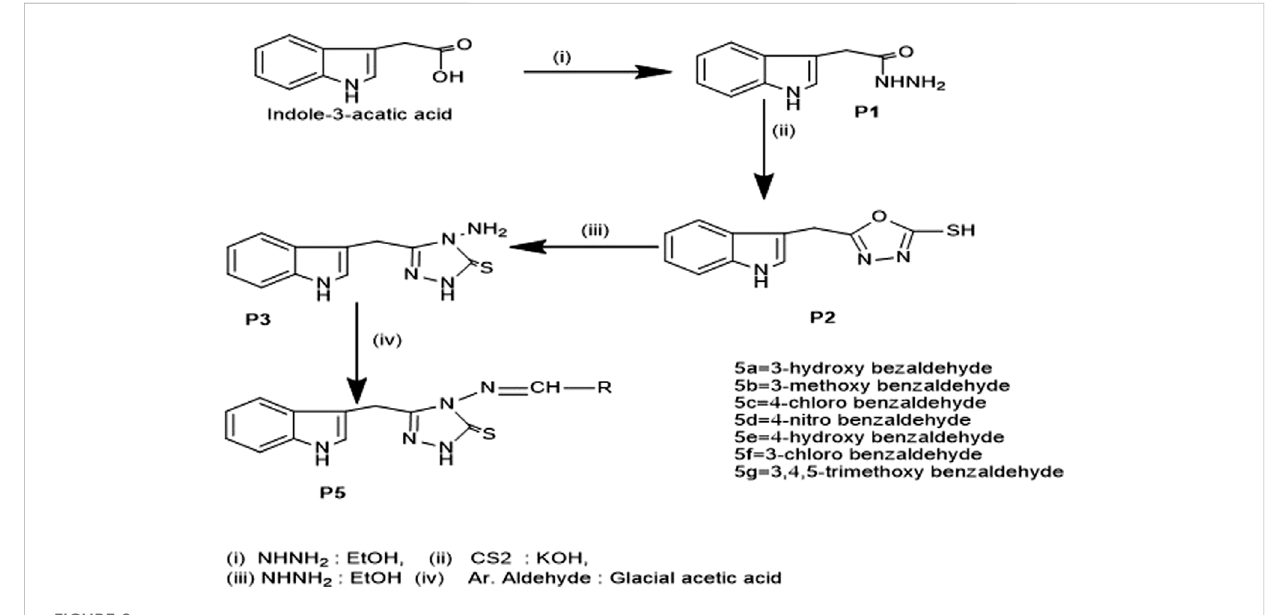
FIGURE 2 General Synthetic Scheme for synthesis of Schiff Bases